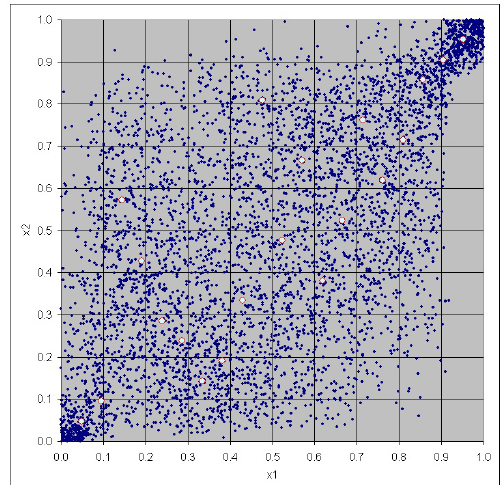
Figure 18. Empirical kernel copula.